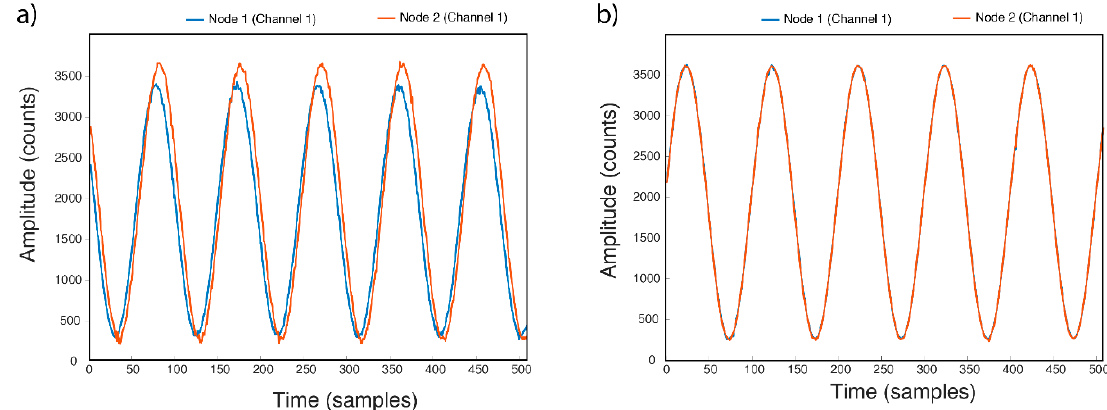
Figure 15. Start delay between Nodes: ( a ) without synchronized start, ( b ) with synchronized start.